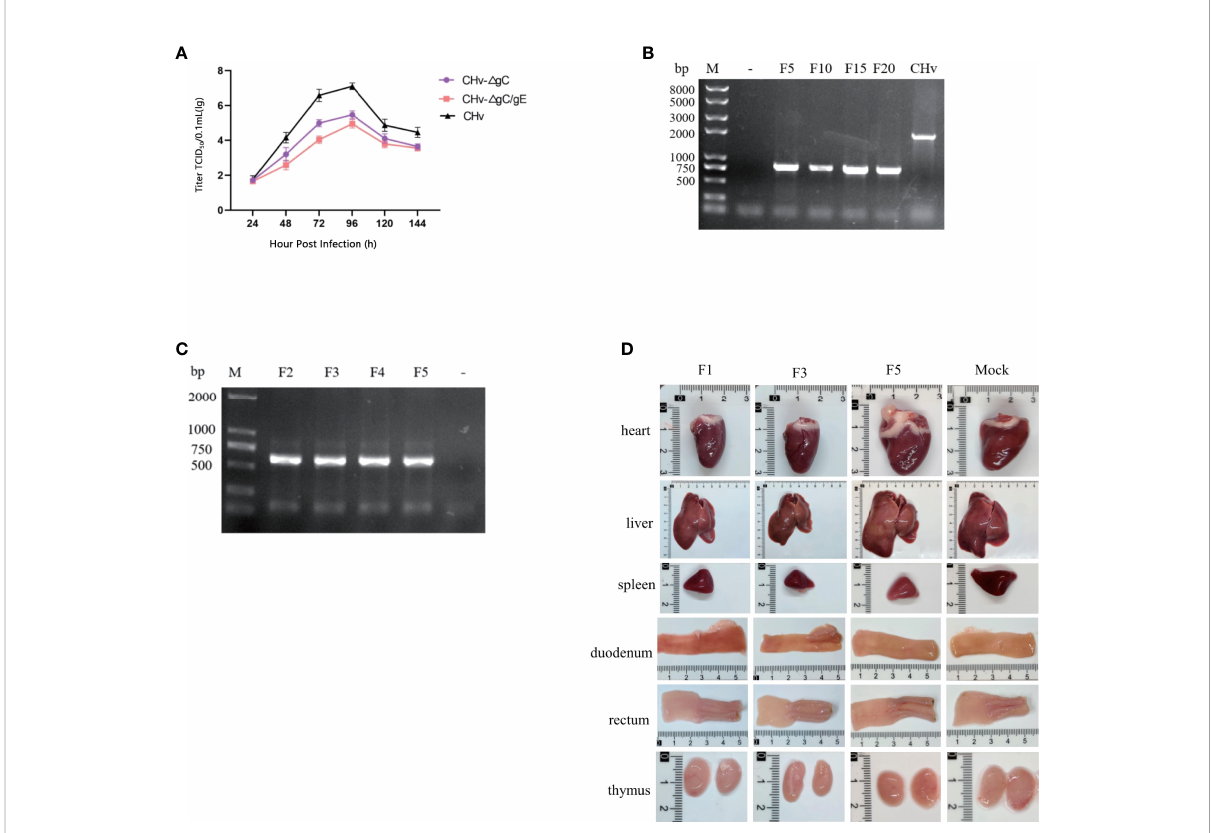
FIGURE 3 Stability of CHv- D gC/gE. (A) DEFs were infected with CHv- D gC/gE, CHv- D gC or CHv (MOI = 0.01). At indicated time points, cells and supernatants were harvested and virus titers were determined. (B, C) Levels of the gE genes were determined with PCR. (B) DEFs were infected with CHv- D gC/gE (10 6 TCID 50 ) and subjected to 20 passages (lines from left to right: Mock, CHv- D gC/gE F5, F10, F15, F20 and Parental virus). (C, D) ducklings were infected (10 6 TCID 50 ) with CHv- D gC/gE and subjected to 5 passages. (C) Identi fi cation of CHv- D gC/gE by PCR using